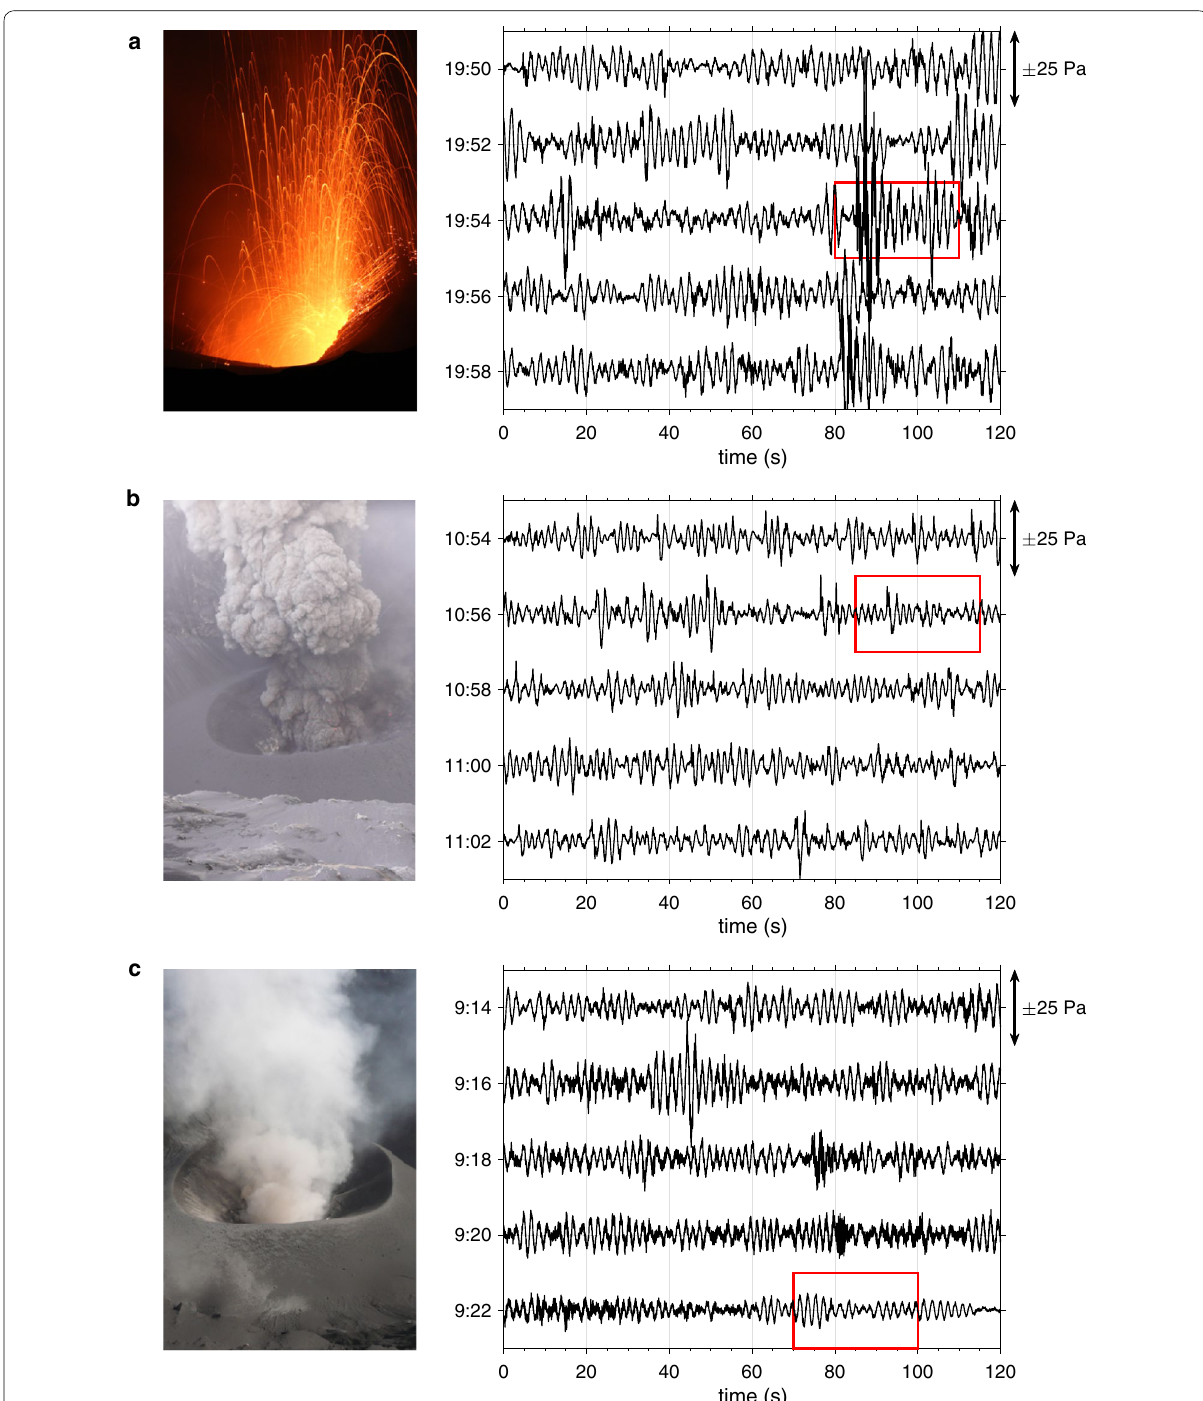
Fig. 2 Surficial phenomena and corresponding infrasound waveforms. Several types of surficial eruptive events ( a Strombolian explosion; b ash ejection; and c emission of gas–steam mixtures) with their corresponding 10-min infrasound waveforms observed at ACM. All pictures in a – c were taken from the SW or SSW rim of the crater at 19:55 on April 18, 2015, 10:57 on January 13, 2015, and 9:23 on March 20, 2015, respectively. Timings of these snapshots were marked in the